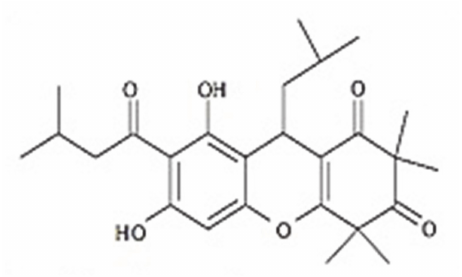
Figure 6. Chemical structure of